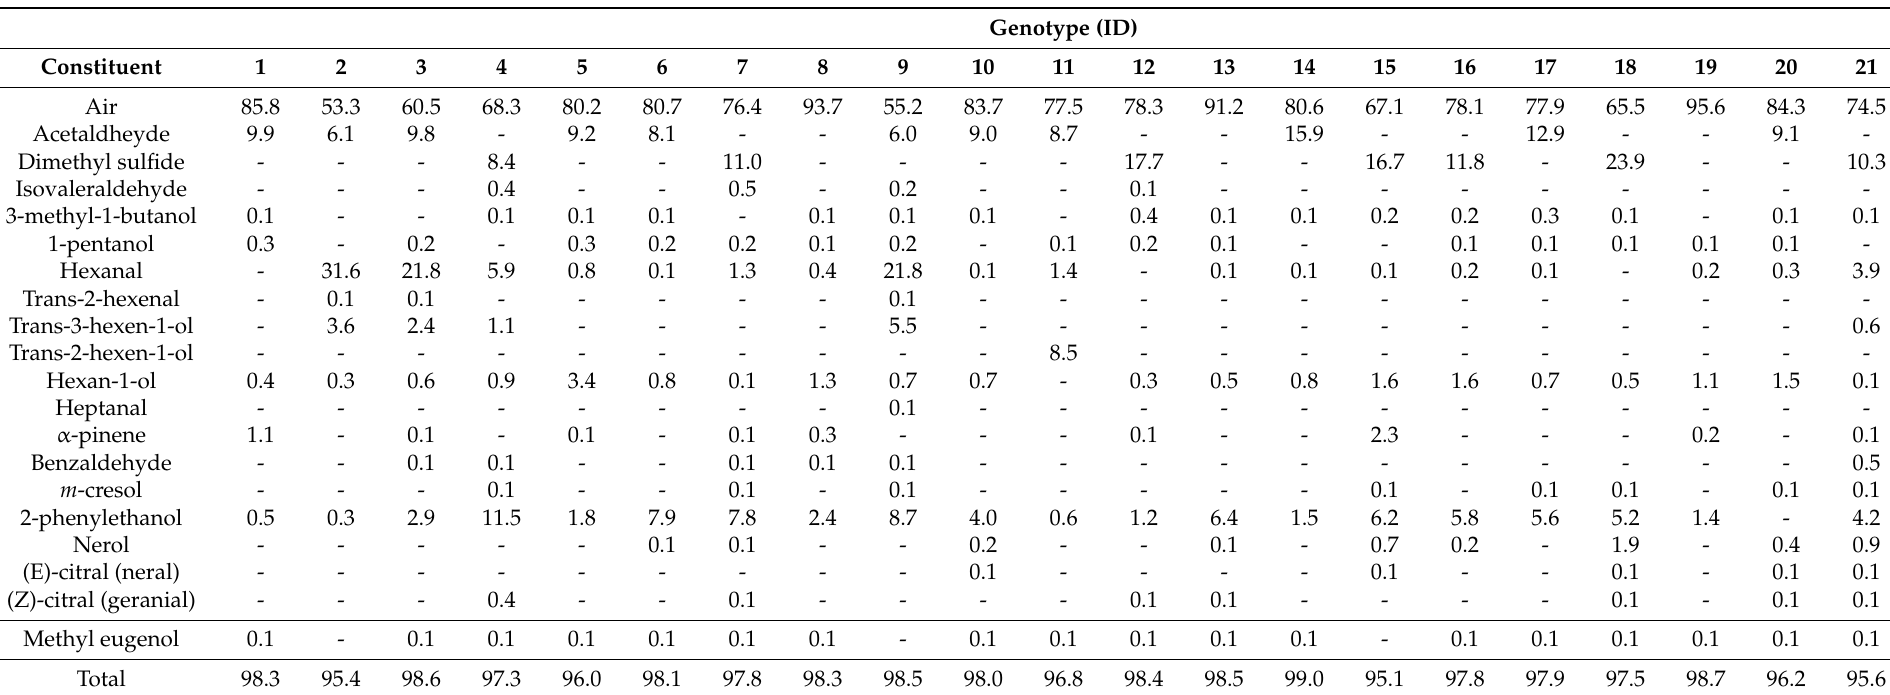
Table 3. Chemical composition and the percentage of relative peak area (%) of volatiles emitted from petals of the 21 studied rose genotypes (see Table 1). All constituents are ordered on the basis of their retention time (see Table